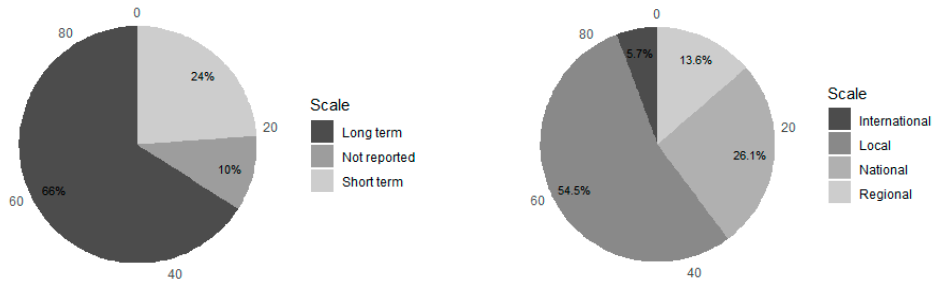
Figure 3. Left panel: temporal scale of mechanisms. Right panel: spatial scale of mechanisms. Apart from environmental objectives, some mechanisms (30 out of 88) also have social objectives, such as improving local livelihoods (20), poverty alleviation (10), and promoting gender equity (1). There is one mechanism having two social objectives.